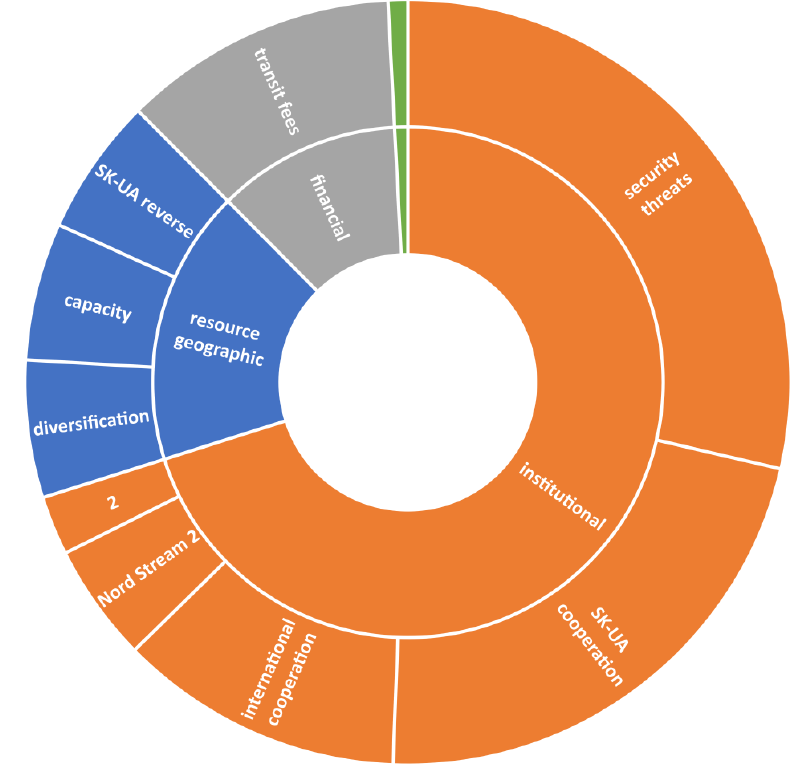
Figure 3. Political discourse on gas transit in Slovakia, 2014–2018. Source: Authors’ calculations. Notes: ecological (green colour) (1); internal affairs (institutional) (2).